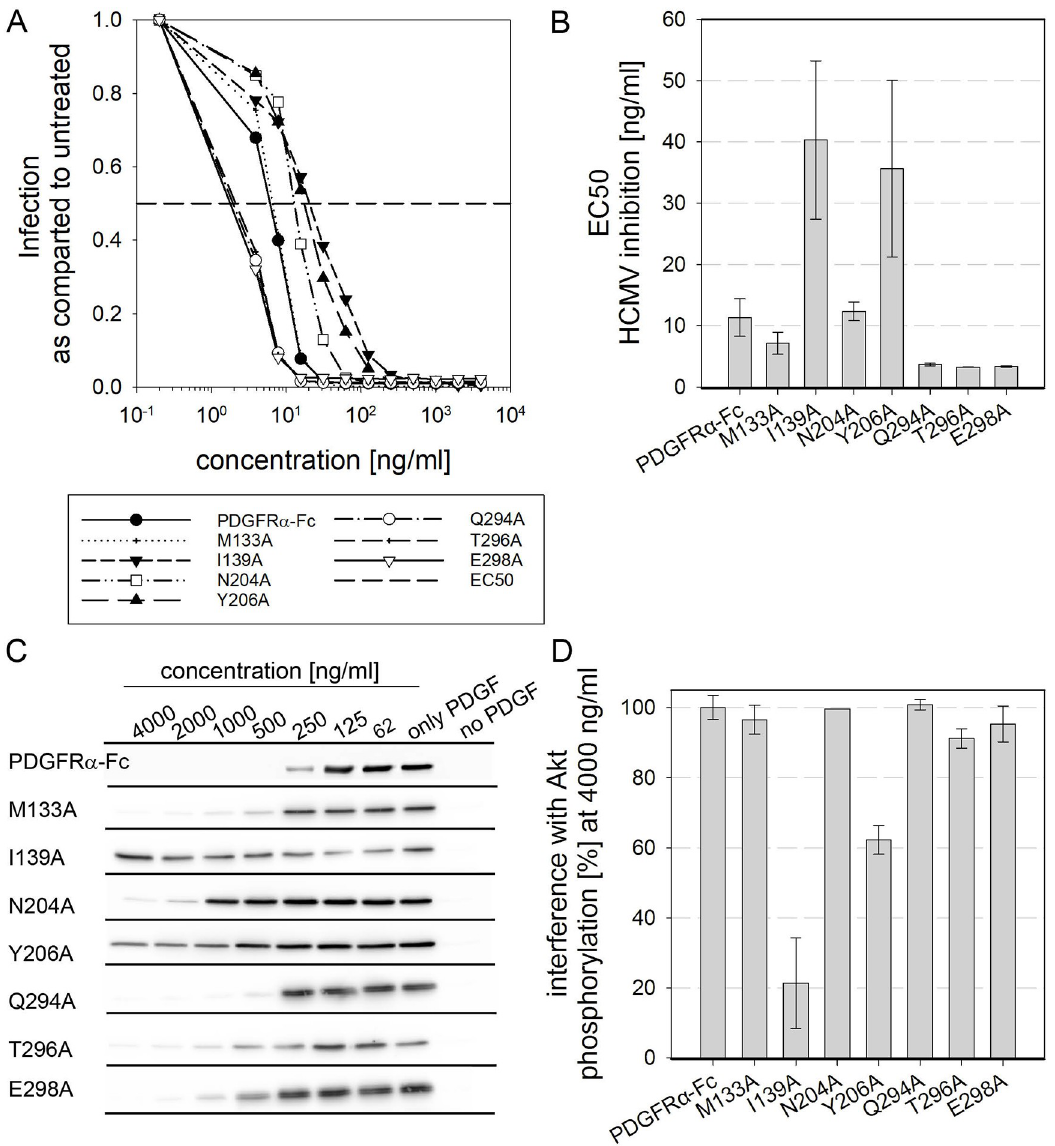
Fig 3. Mutation of isoleucine 139 and tyrosine 206 reduces sequestration of PDGF-BB. A + B: Quantification of HCMV inhibition by PDGFR α -Fc alanine exchange mutants was assessed by preincubation of the HCMV TB40-BAC4-IE-GLuc reporter virus with PDGFR α -Fc derivatives before infection of fibroblasts. The degree of infection was measured relative to a virus only condition. A depicts the average dose-response curves as calculated from at least 3 independent experiments. B: The individual dose-response curves from each experiment were used as a basis to calculate the half-maximal effective concentrations (EC50s) needed for HCMV inhibition. C + D: Biological interference of PDGFR α -Fc alanine exchange mutants with PDGF-dependent signaling was tested by preincubation of 50 ng/ml PDGF-BB with various concentrations of PDGFR α -Fc derivatives before stimulation of fibroblasts. Immunoblot staining of Phospho-Akt served as a measure for PDGF induced signaling. C shows immunoblot examples and D summarizes the interference of 4000 ng/ml of the different PDGFR α -Fc variants with Akt phosphorylation. All signals were normalized to actin to control for consistent loading. 100% interference equals complete inhibition of Akt phosphorylation to the level of cells that did not receive PDGF-BB. 0% interference corresponds to full signal intensity to the level of cells stimulated with untreated PDGF-BB. Summarized are experiments using two independent preparations of the soluble receptors. Error bars indicate standard error of the